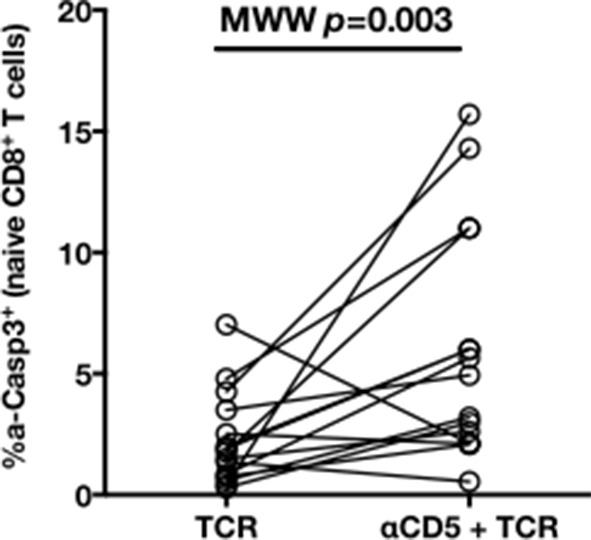
CD5 blockade leads to increased activation-induced cell death after TCR stimulation in HD.Percentages of a-Casp3+ (24 hr) after TCR stimulation in naïve CD8+ T cells from HD, with or without prior CD5 blockade with α-CD5 antibodies.